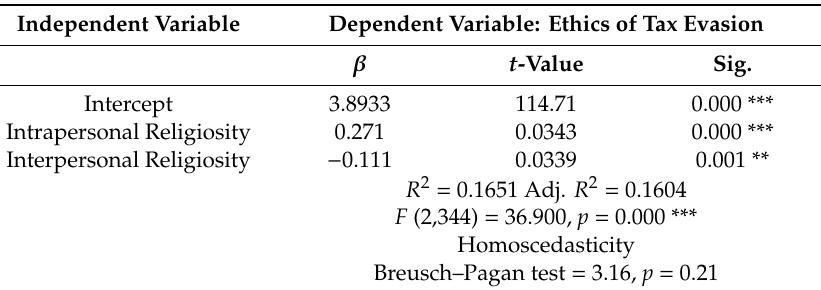
Table 7. Regression Analysis of Model